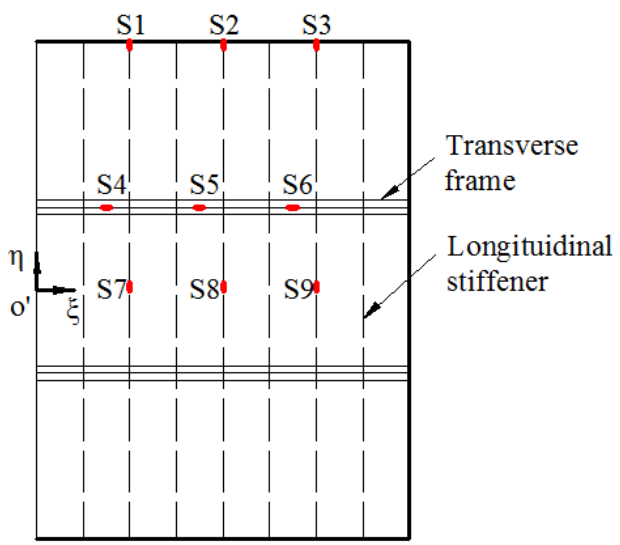
Figure 3. One side of the 3D wedge. Table 1. Structural parameters of the stiffened plate.